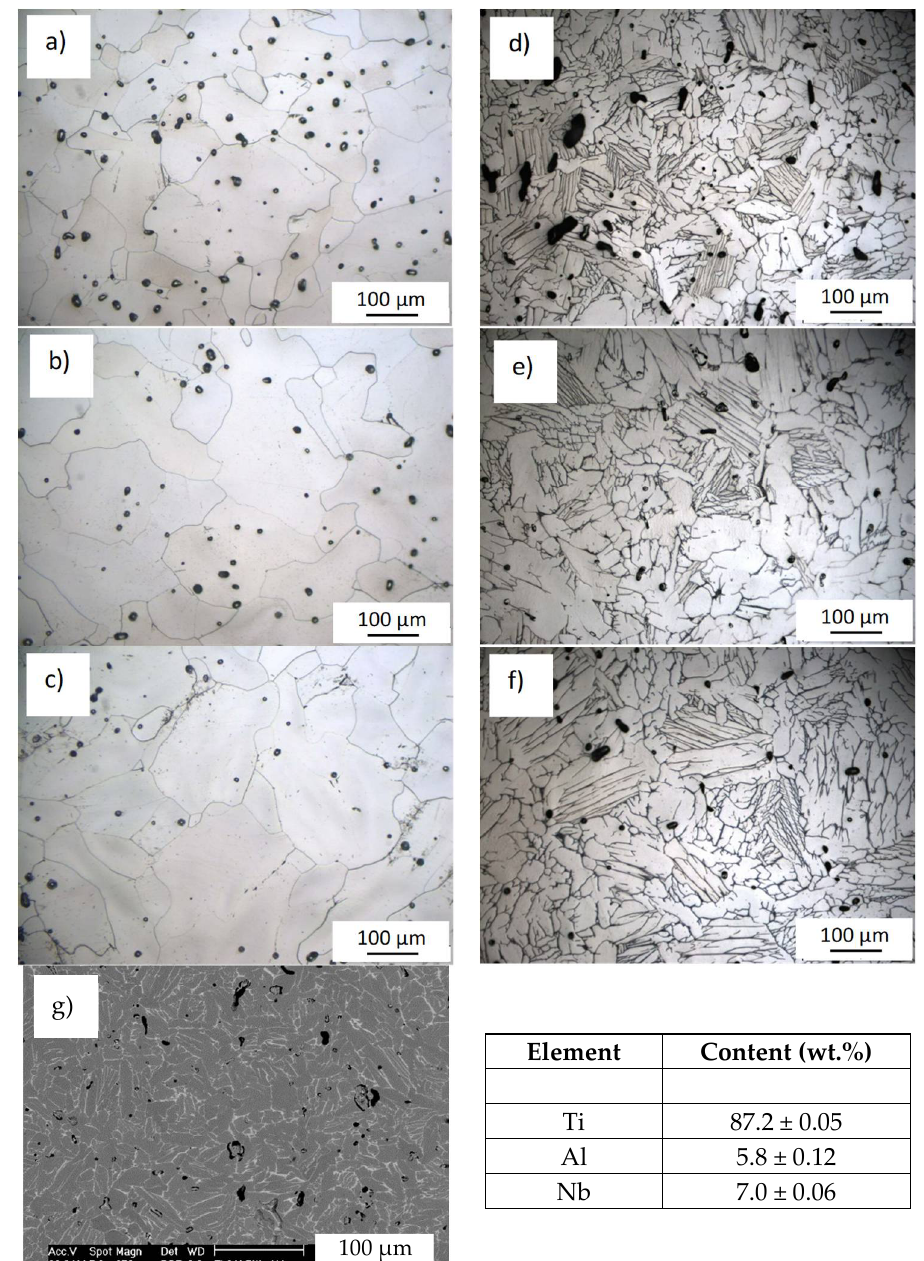
100 μm Figure 2. Representative optical micrographs of the P/M Ti ( a – c ) and Ti-6Al-7Nb ( d – f ) alloy: ( a ) and ( d ) 1250 °C—2 h, ( b ) and ( e ) 1350 °C—2 h, and ( c ) and ( f ) 1350 °C—4 h; and SEM micrograph ( g ) and related overall EDS chemical analysis of the Ti-6Al-7Nb alloy sintered at 1250 °C—2 h.